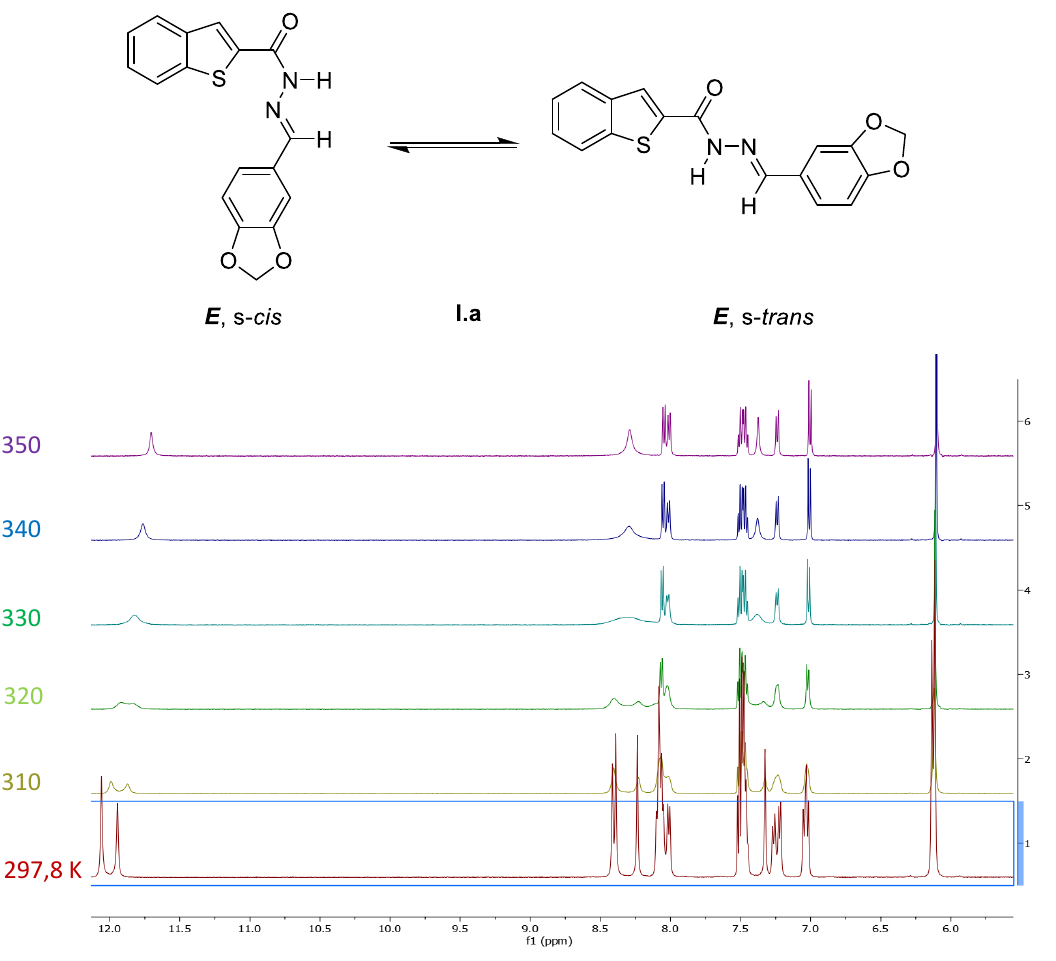
Figure 2. 1 H NMR spectra of I.a at different temperatures.